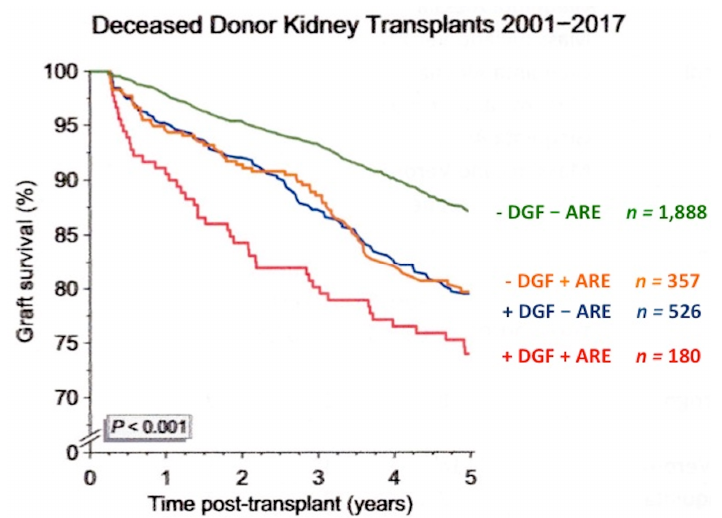
Figure 2. Influence of delayed graft function (DGF) and acute rejection (ARE) on graft survival in kidney transplantation from deceased donor. The individual impact of DGF and ARE on five-year graft survival from month three was similarly strong and independent each other. If the early adverse events occurred simultaneously (+DGF+ARE), their impact was more impressive (obtained from CTS